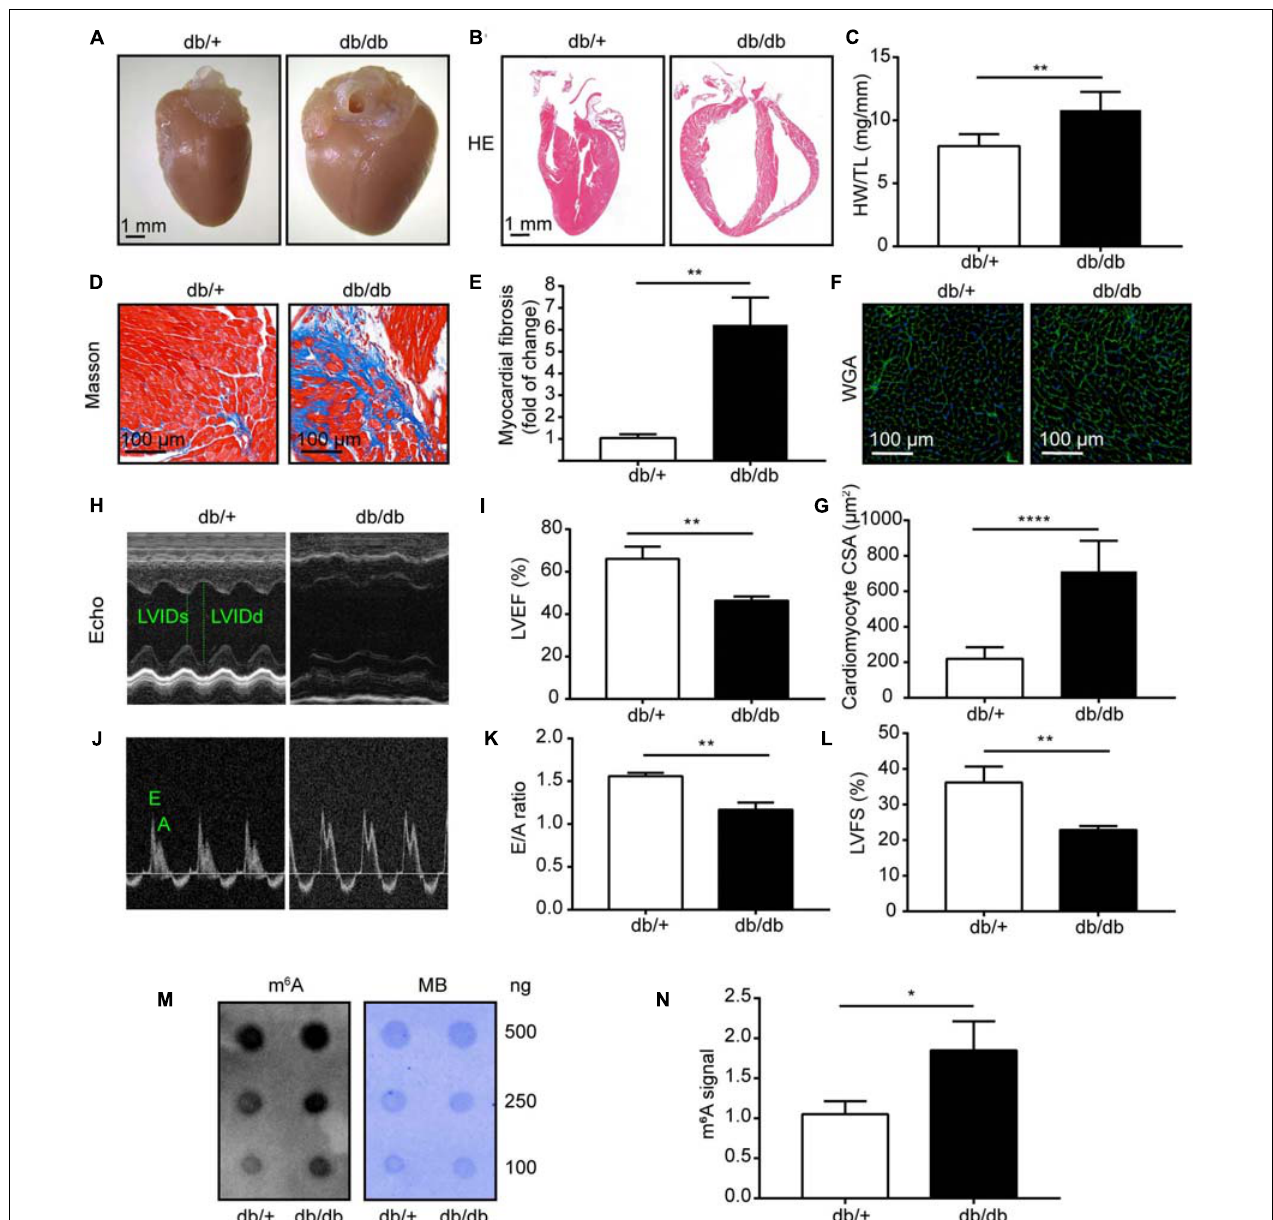
FIGURE 1 | Heart morphology and function were significantly changed in db/db (DCM) mice compared with those in normal control (NC) mice. (A) Representative images of hearts from DCM and NC mice. (B) Gross morphology of mouse hearts stained with hematoxylin and eosin (HE); scale bar, 1 mm. (C) Ratio of heart weight to tibia length. (D,E) Representative images of Masson trichrome stained (Masson) hearts and quantitative analysis of interstitial fibrosis; scale bar, 100 µ m. (F,G) Representative images of wheat germ agglutinin staining (WGA) and quantitative analysis of cardiomyocyte cross-sectional area; scale bar, 100 µ m. (H) Representative M-mode echocardiography images; left ventricular internal diameter in systole (LVIDs) and left ventricular internal diameter in diastole (LVIDd) are labeled. (I) LVEF, left ventricular ejection fraction. (J,K) Representative Doppler echocardiography images and E/A ratio. (L) LVFS, left ventricular fractional shortening. (M) Representative dot blot showing m 6 A levels in hearts from DCM and NC mice; MB, methylene blue staining. (N) Quantification of m 6 A levels in hearts from DCM and NC mice. DCM, diabetic cardiomyopathy group; NC, normal control group; n = 5. Data are presented as mean ± SEM; differences between two groups were analyzed using the Student’s t -test; **** P < 0.0001, ** P < 0.01, * P < 0.05 vs. NC.